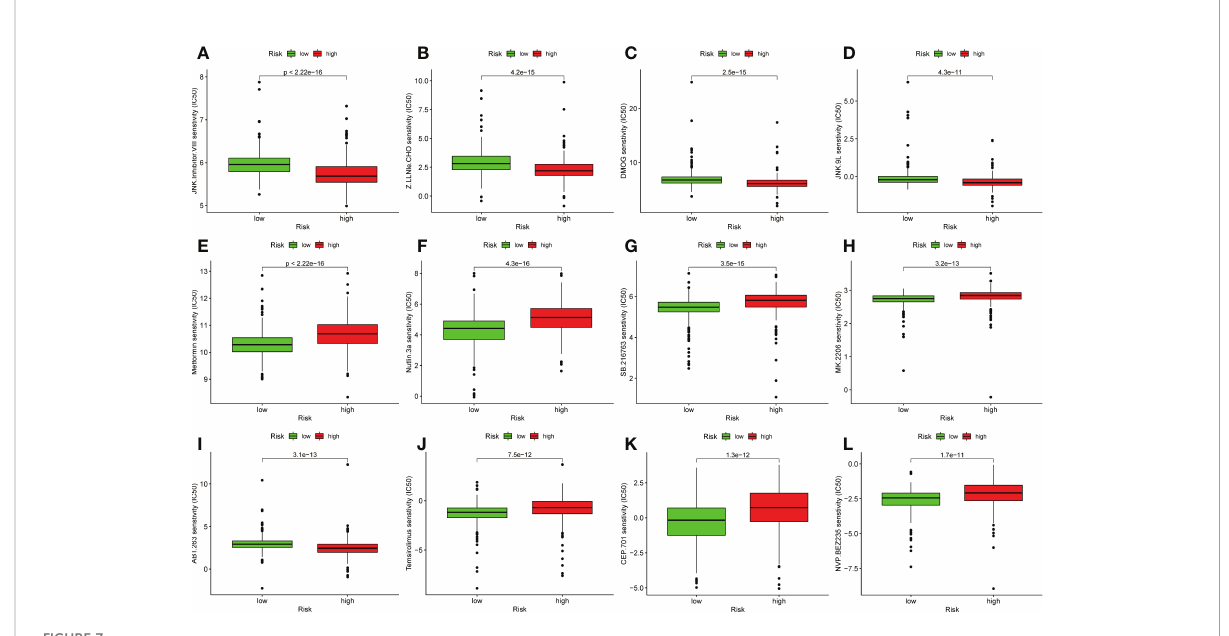
FIGURE 7 Comparison of susceptibility to twelve therapeutic agents between high-risk and low-risk groups. (A) IC50 of JNK inhibitor VIII high and low risk groups. (B) IC50 of Z.LLNle.CHO high and low risk groups. (C) IC50 of DMOG in high and low risk groups. (D) IC50 of JNK.9L in high and low risk groups. (E) IC50 of Metformin in high and low risk groups. (F) IC50 of Nutlin.3a in high and low risk groups. (G) IC50 of SB.216763 in high and low risk groups. (H) IC50 of MK.2206 in high and low risk groups. (I) IC50 of ABT.263 in high and low risk groups. (J) IC50 of Temsirolimus in high and low risk groups. (K) IC50 of CEP.701 in high and low risk groups. (L) IC50 of NVP.BEZ235 in high and low risk